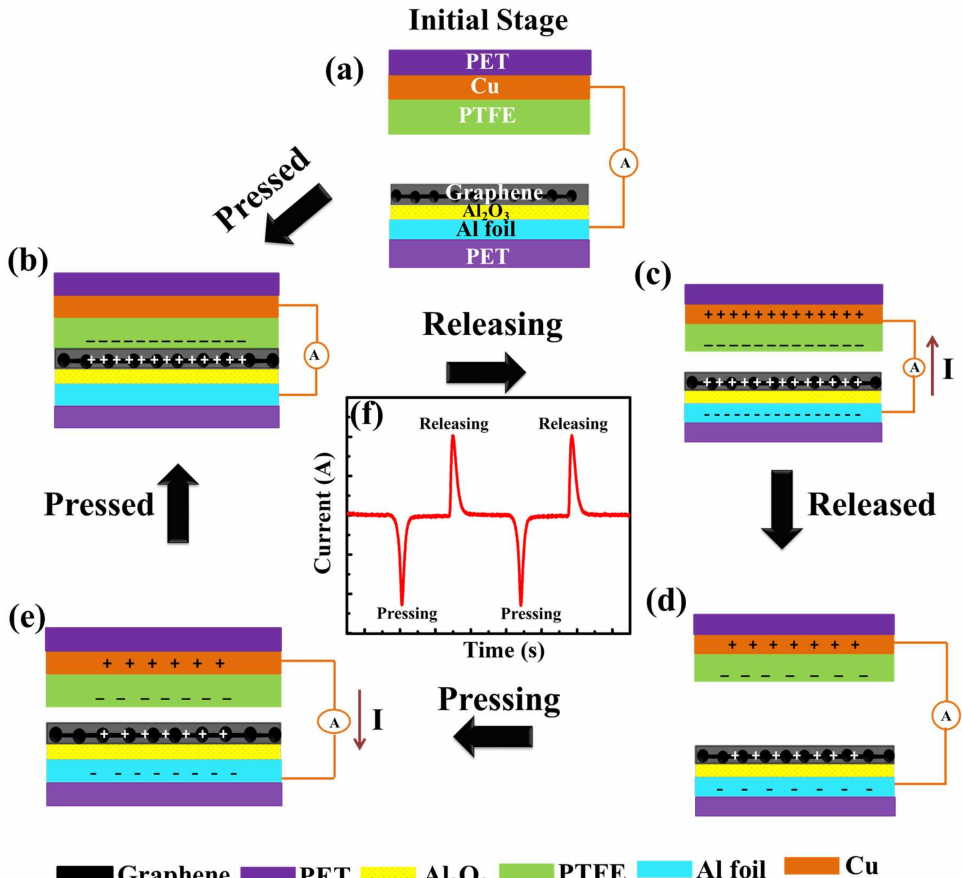
Figure 5. Schematic diagram showing the working mechanism of Gr-TENG with Al 2 O 3 . ( a ) Initial stage of two different triboelectric layers when no external impact is applied. ( b ) Triboelectric charges are generated on the surfaces of graphene and PTFE when they are in contact with each other. ( c ) Separation of graphene and the PTFE triboelectric layer begins. The current flows from the bottom electrode (graphene) to the top electrode (PTFE) to maintain electrical equilibrium. ( d ) Complete separation of the graphene and PTFE triboelectric layer and reaching electrical equilibrium causes no electron flow. ( e ) Pressing the graphene and PTFE triboelectric layer into contact again causes the current to flow from the top electrode to the bottom electrode. ( f ) One typical signal of Gr-TENG with Al 2 O 3 upon pressing and